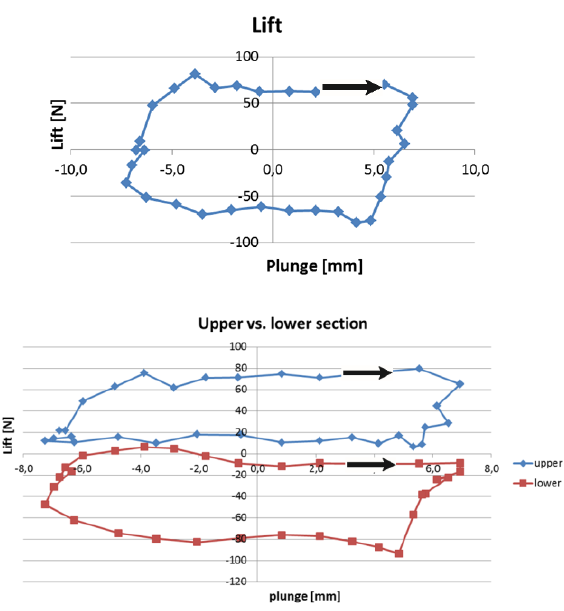
Fig. 9. Lift force in dependency on plunge coordinate, for entire shape, for upper and lower sides, Ma = 0.45.